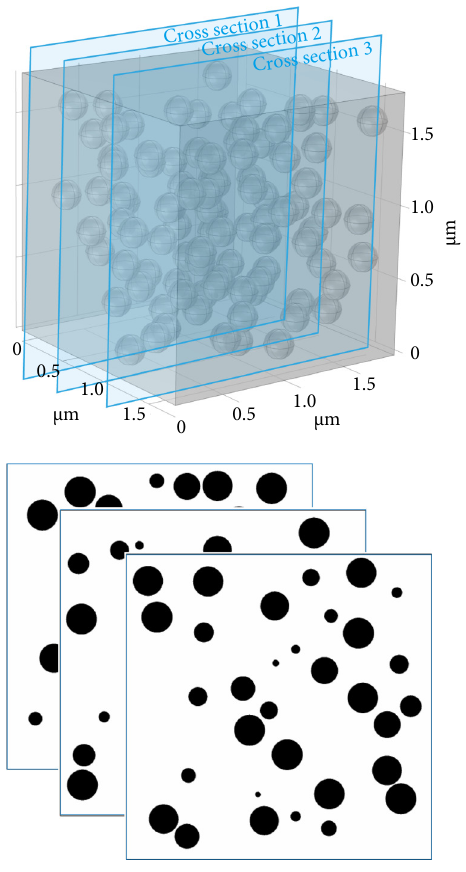
Fig. 2 Images for ConvNet network